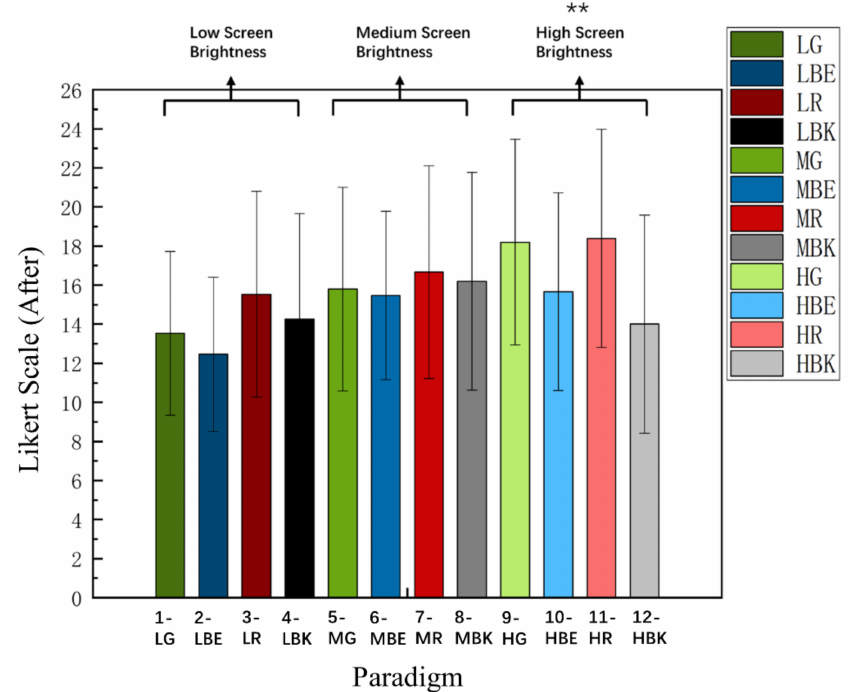
Figure 6. Comparison of the mean values and SD of Likert Scale (VFS) for 12 paradigms over 15 subjects after each run of the experiment. Statistics were assessed by one-way repeated-measures ANOVA. ** p <